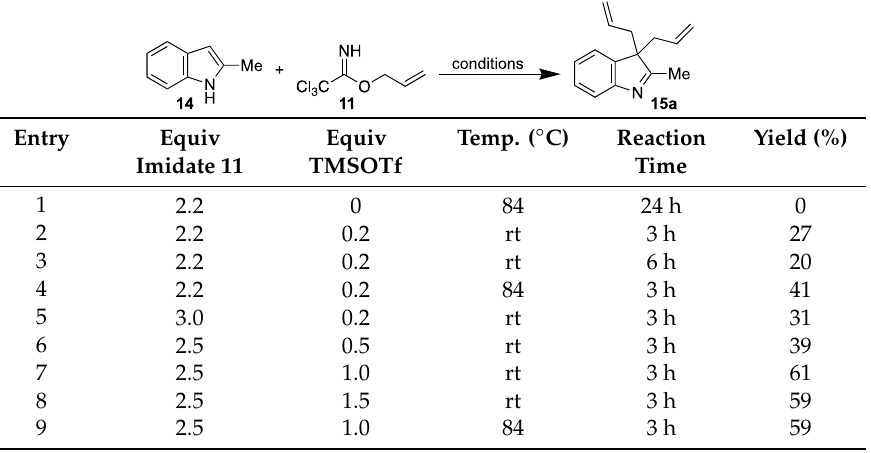
Table 1. Optimization of the diallylation reaction.